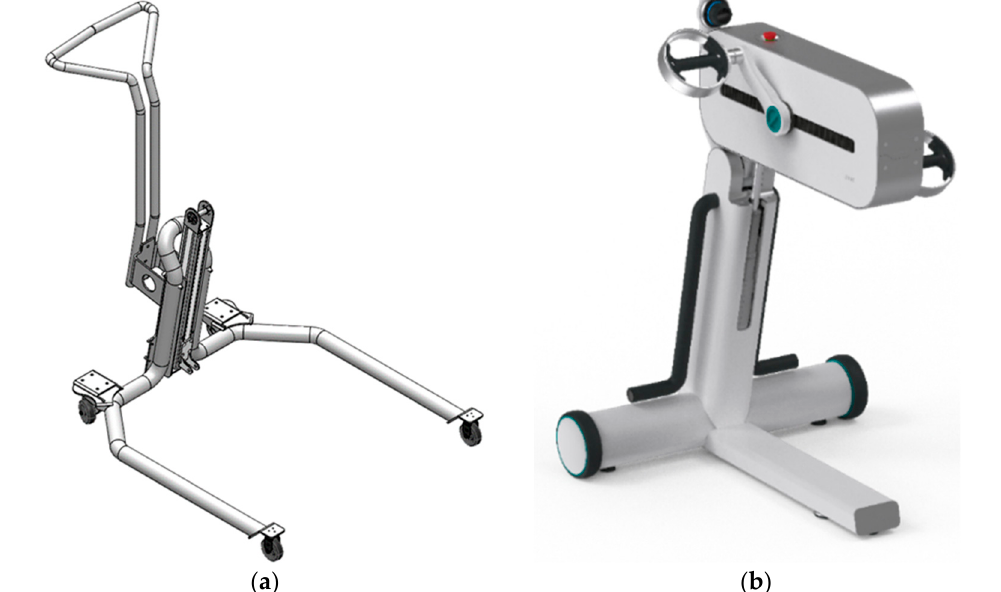
Figure 10. From the left: ( a ) the First LEPRE Structural Shape, ( b ) the Structural Shape of the LEPRE Rehabilitation Device in the CE-marked version.